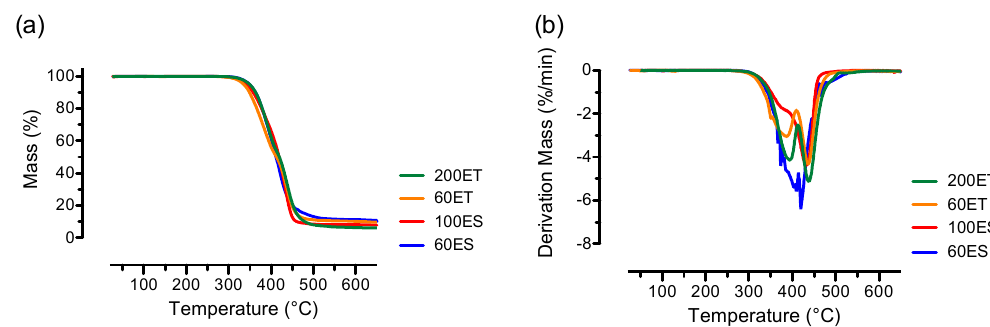
Figure 4. Thermal stability evaluations of the various PU films, showing ( a ) representative thermal gravimetric analysis (TGA) curves on percentage mass loss with onset temperatures ranged between 337 to 355 °C; and ( b ) representative dTG curves where the 60ES and 100ES groups exhibited single peak decomposition temperature and the 60ES and 200ES groups displayed a two-step decomposition process. Table 2. dTG temperatures and their corresponding percentage mass losses of the various PU films. First Step Second Step